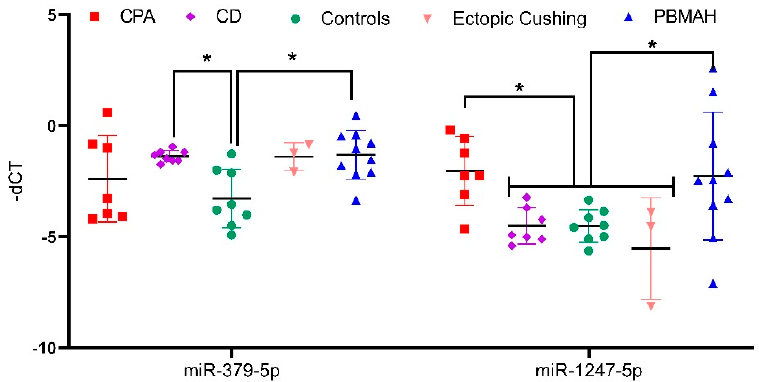
Figure 4. QPCR analyses of significantly upregulated miRNAs from validation QPCR. Data are represented as mean ± standard deviation (SD) of − dCT values. Housekeeping gene: miR-16-5p. Statistics: ANOVA test with Bonferroni correction to detect significant differences between patient groups with at least a significance of p -value < 0.05 (*).